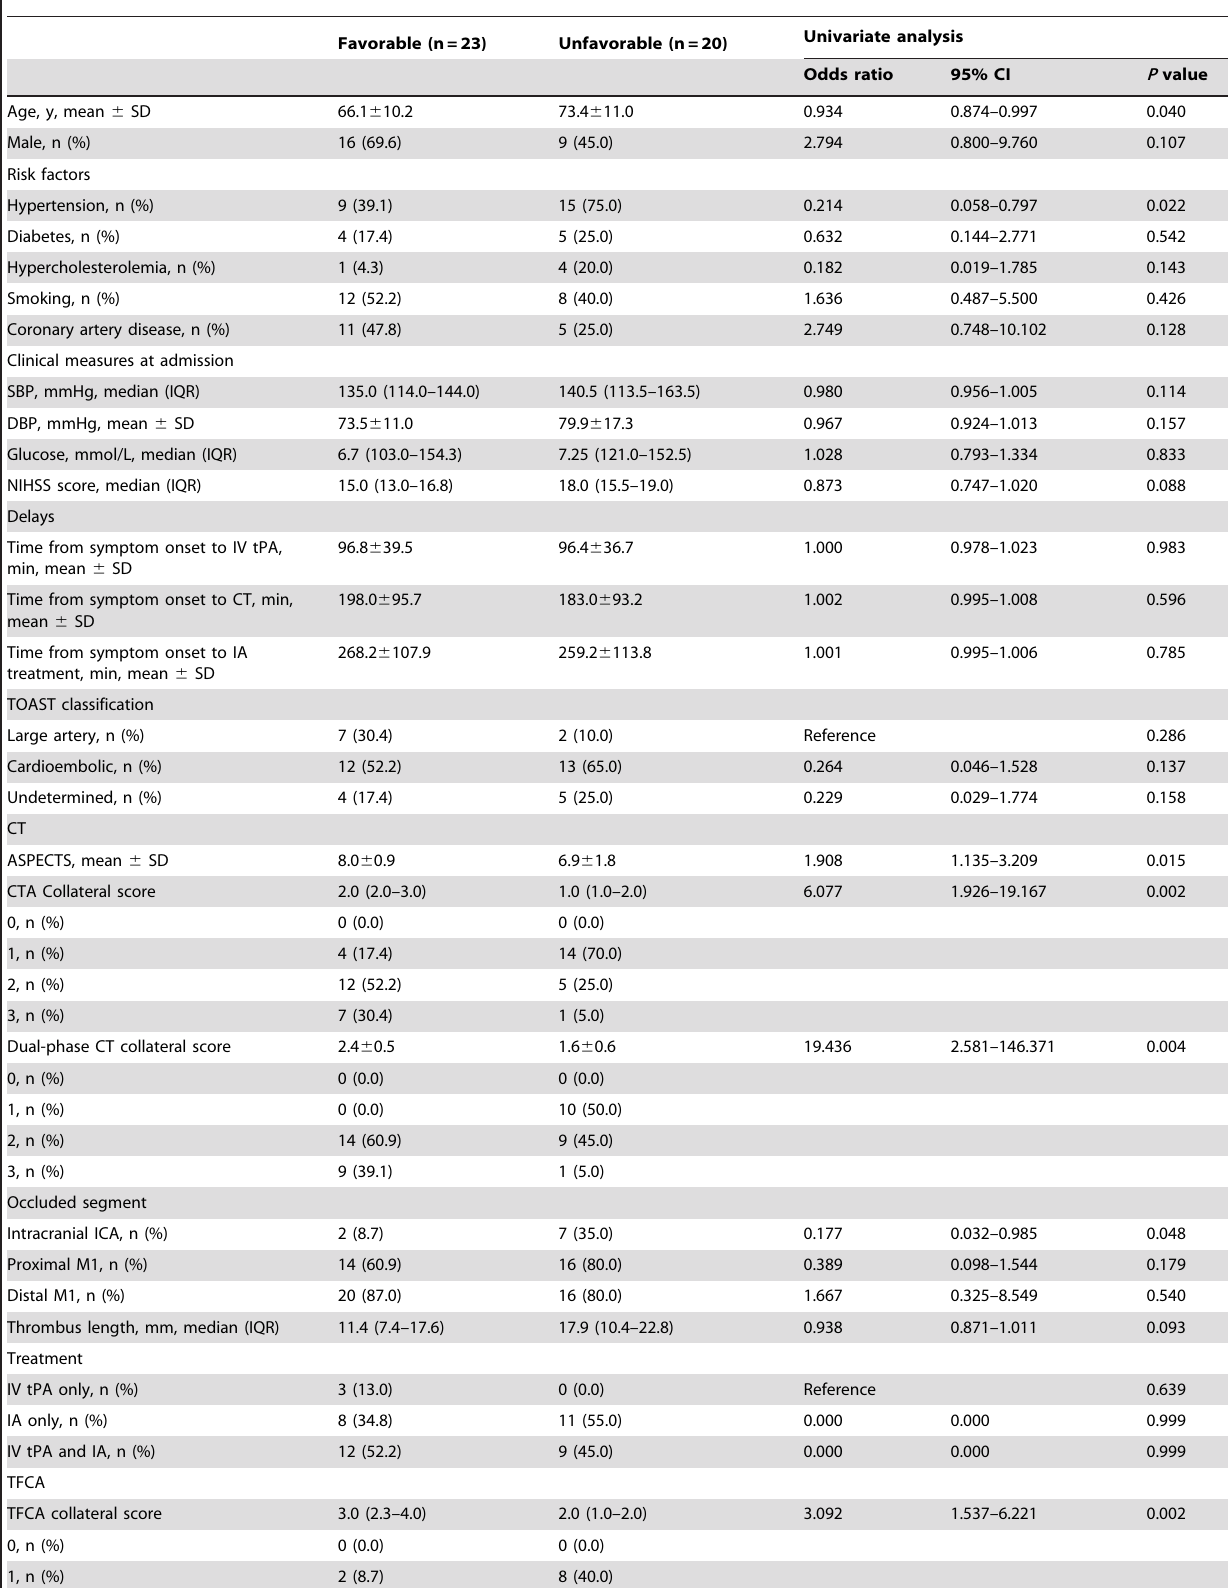
Table 2. Univariate analysis for favorable clinical outcome (mRS # 2) at 3 months.